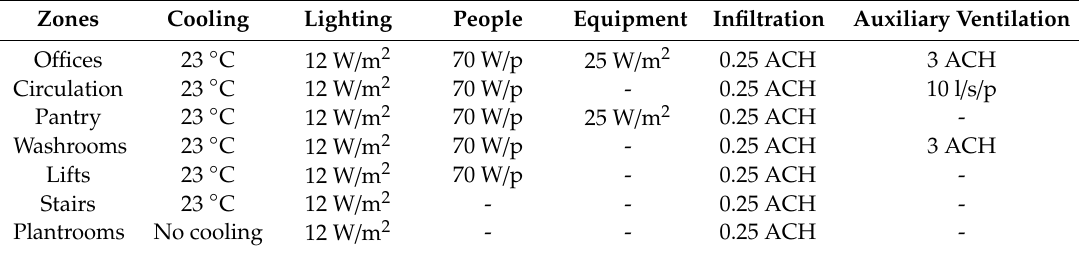
Table 3. Thermal templates assigned for the building (CIBSE guide A and B).